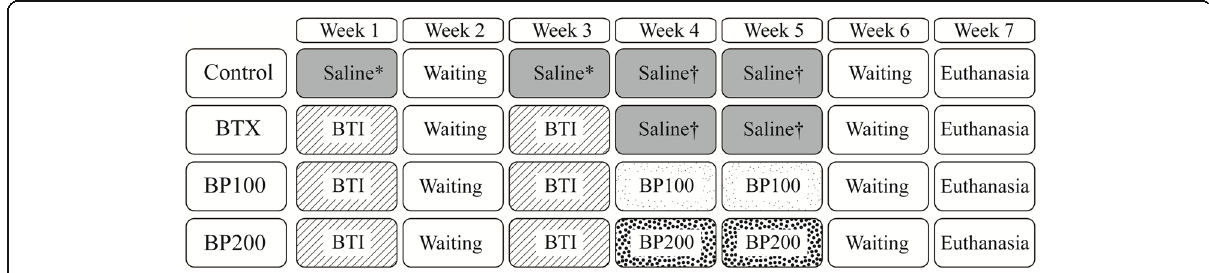
Fig. 1 Experiment design. 3.75 U of botulinum toxin and the same dose of normal saline were administered in weeks 1 and 3. In weeks 4 and 5, 100 μ g/kg or 200 μ g/kg of bisphosphonate (zoledronic acid) was administered to the respective groups. A total of 100 μ g/kg of normal saline was administered to both the control and BTX groups. All animals were euthanized on week